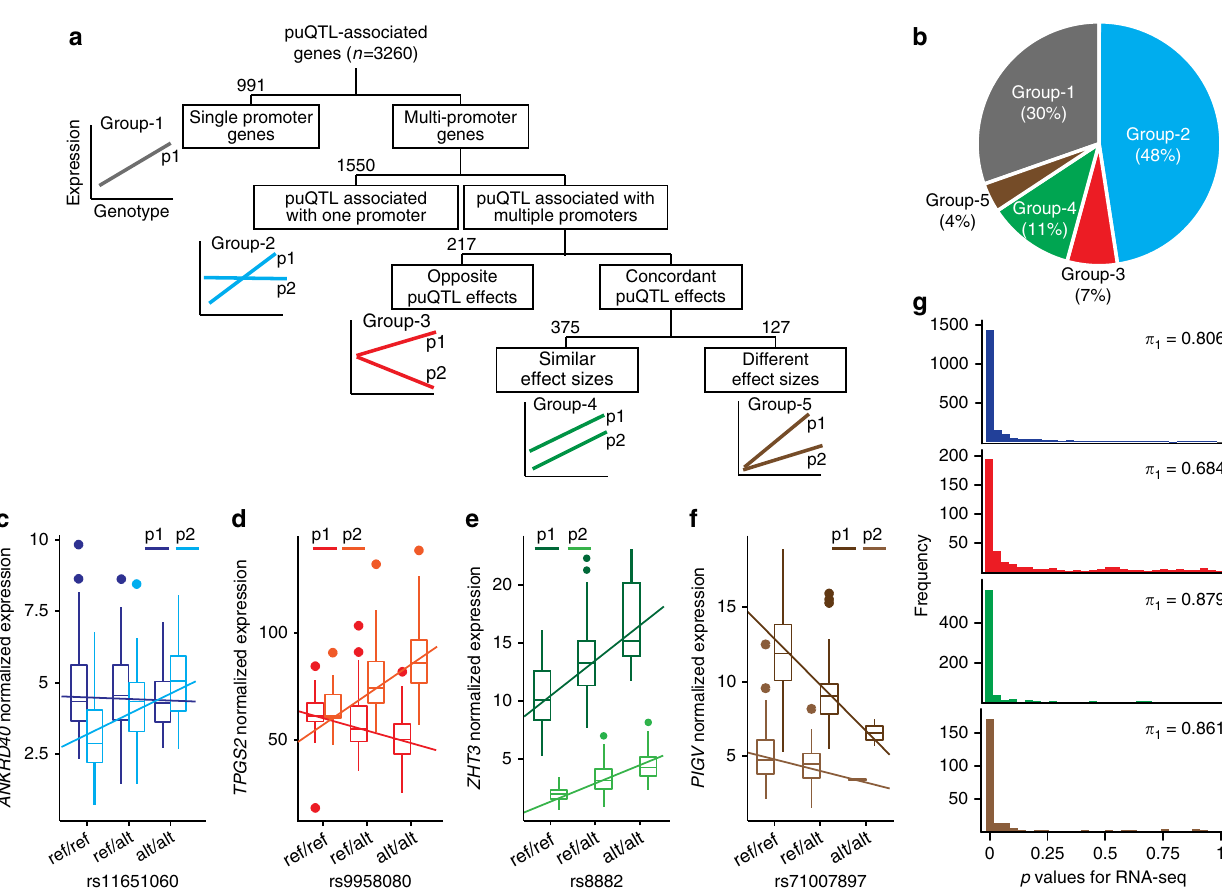
Fig. 2 puQTL-associated gene classi fi cation. a Classi fi cation procedure for the puQTL-associated genes. b Relative size of each group of puQTL-associated genes. c – f Representative puQTLs examples for group-2 ( c ), group-3 ( d ), group-4 ( e ), and group-5 ( f ). g Replication of puQTLs for each group in RNA-seq data using π 1